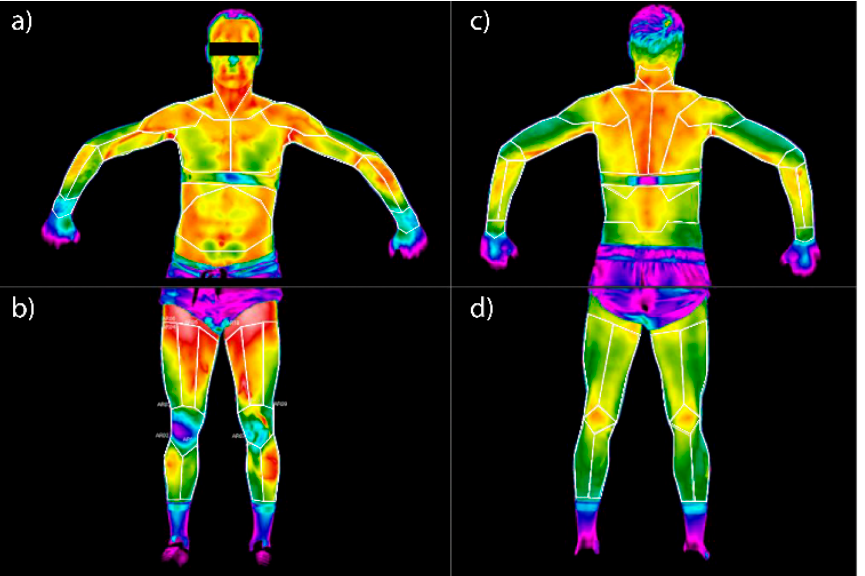
Figure 1. Regions of Interest (ROI) on the surface of the human body used in the research: ( a ) anterior surface of the chest and upper limbs, ( b ) anterior surface of the lower limbs, ( c ) posterior surface of the chest (back) and upper limbs, ( d ) posterior surface of the lower limbs. flexor, 2—left wrist flexor, 3—right biceps muscle, 4—left biceps muscle, 5—left triceps muscle, 6—left triceps muscle, 7—right pectoral muscle, 8—left major pectoral muscle, 9—right anterior dentate muscle, 10—left dentate anterior muscle, 11—right rectus muscle, 12—right trapezius muscle, 13—left trapezius muscle, 14—gastrocnemius muscle right, 15—left gastrocnemius muscle, 16—right quadriceps muscle, 17—left quadriceps muscle, 18—right deltoid muscle, 19—left deltoid muscle, 20—right latissimus dorsi muscle, 21—left latissimus dorsi muscle.